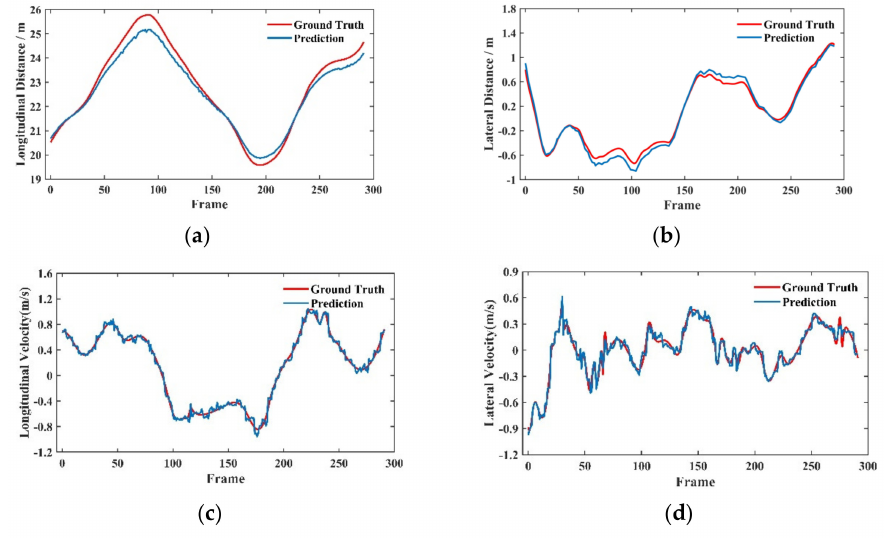
Figure 7. Real–time variation curve of distance and speed of the target vehicle in the forward- following scenario. ( a ) Longitudinal distance, ( b ) Lateral distance, ( c ) Longitudinal velocity, ( d ) Lateral velocity.